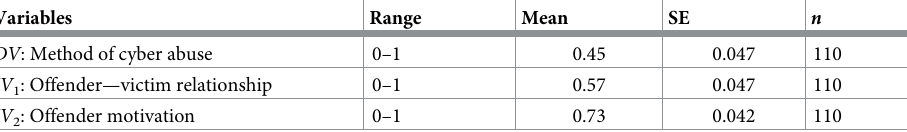
Table 2. Descriptive statistics for response and explanatory variables in GLM analysis of cyber abuse.